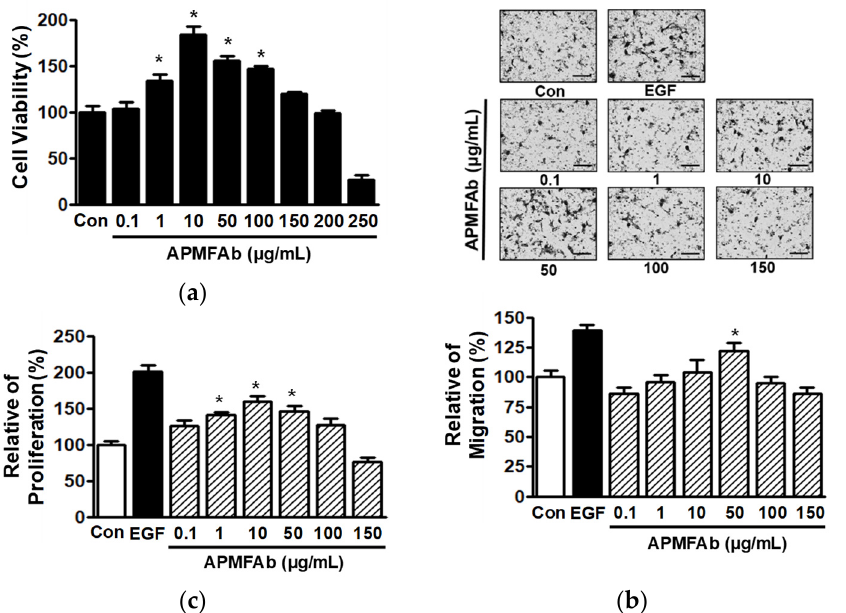
Figure 1. Effects of Angelica polymorpha Maxim. flower absolute on HaCaT cell migration and proliferation. ( a ) Cell viability. HaCaT cells were treated with Angelica polymorpha Maxim. flower absolute (APMFAb; 0.1–250 µ g/mL) for 48 h. Viabilities were measured using the WST assay ( n = 5). ( b ) Cell migration. HaCaT cells were exposed APMFAb (0.1–150 µ g/mL) for 210 min. Migration levels were determined using a Boyden chamber assay as described in Materials and Methods (upper panels). Representative images of the results. Black spots indicate migrated cells. Scale bar = 100 µ m. (lower panels) Graphical representation of the results. Recombinant human epidermal growth factor (EGF: 1 ng/mL) was used as the positive control. Results are presented as mean percentages ± SEMs of non-treated controls (Con) ( n = 4). * p < 0.05 vs. non-treated cells. ( c ) Cell proliferation. HaCaT cells were incubated with APMFAb (0.1–150 μ g/mL) for 48 h, and proliferations were deter- mined using a BrdU incorporation assay as described in Materials and Methods. Recombinant hu- man epidermal growth factor (EGF: 50 ng/mL) was used as the positive control. Results are pre- sented as mean percentages ± SEMs of non-treated controls (Con) ( n = 5). * p < 0.05 vs. non-treated cells.